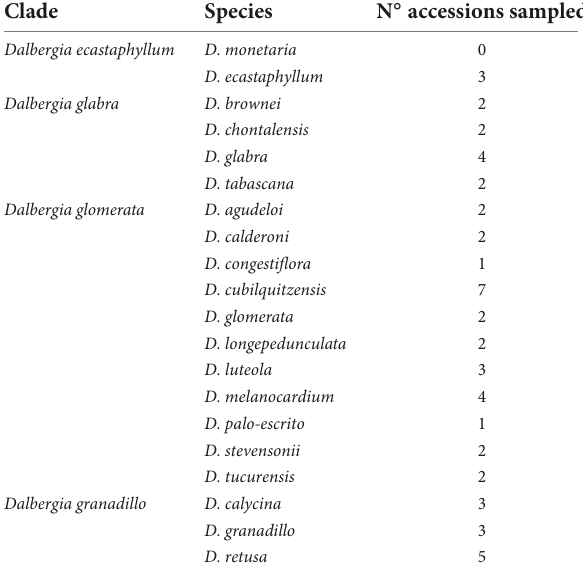
TABLE 2 The phylogenetic clades recognized in the present study for Mexican species of Dalbergia . Clade Species N ◦ accessions